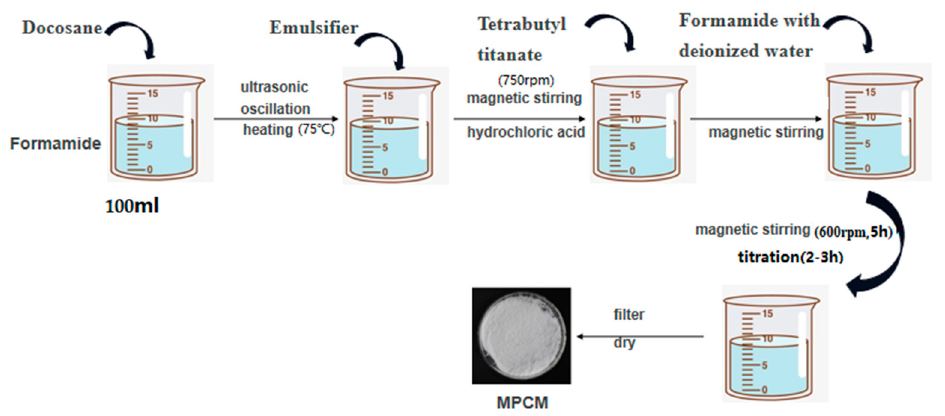
Figure 1. A flow chart of the preparation method. Table 3. List of all